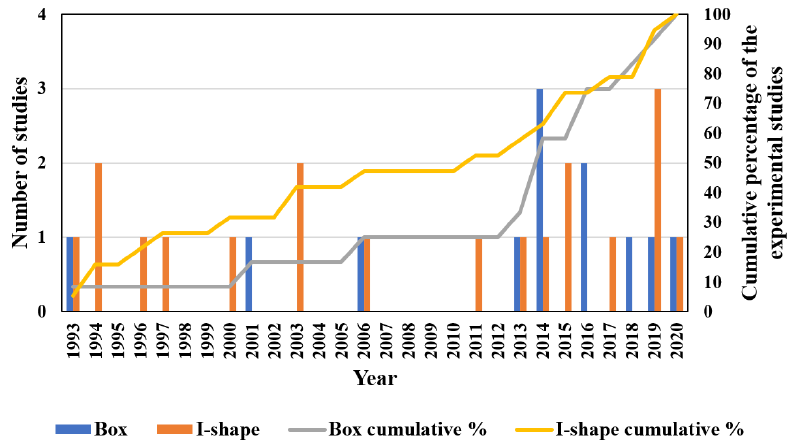
Figure 3. The number of experimental studies of local buckling undertaken on I-shape versus box shape for civil structural applications (Box-shape: [17,29,53,55,56,72,95,96,98,100,101,104] and I-shape: [17,53,61,62,64,66–72,77,79,81,89–92]).